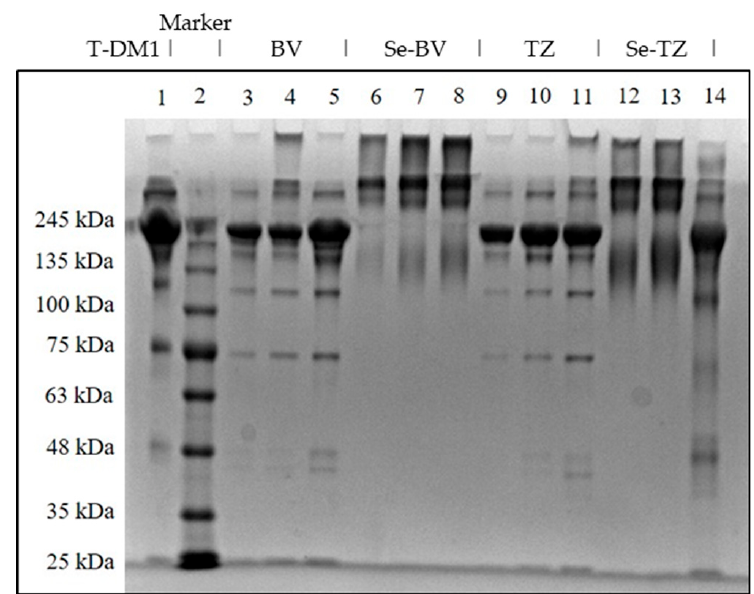
Figure 3. SDS-PAGE of Native and Se-conjugated mAbs under reducing conditions followed by Coomassie Blue R-250 staining. Lane 1: Kadcyla ® 20 µg; Lane 2: Marker; Lane 3: BV 5 µg; Lane 4: BV 10 µg; Lane 5: BV 20 µg; Lane 6: Se-BV 5 µg; Lane 7: Se-BV 10 µg; Lane 8: Se-BV 20 µg; Lane 9: TZ 5 µg; Lane 10: TZ 10 µg; Lane 11: TZ 20 µg, Lane 12: Se-TZ 10 µg; Lane 13: Se-TZ 20 µg; Lane 14: Gamma